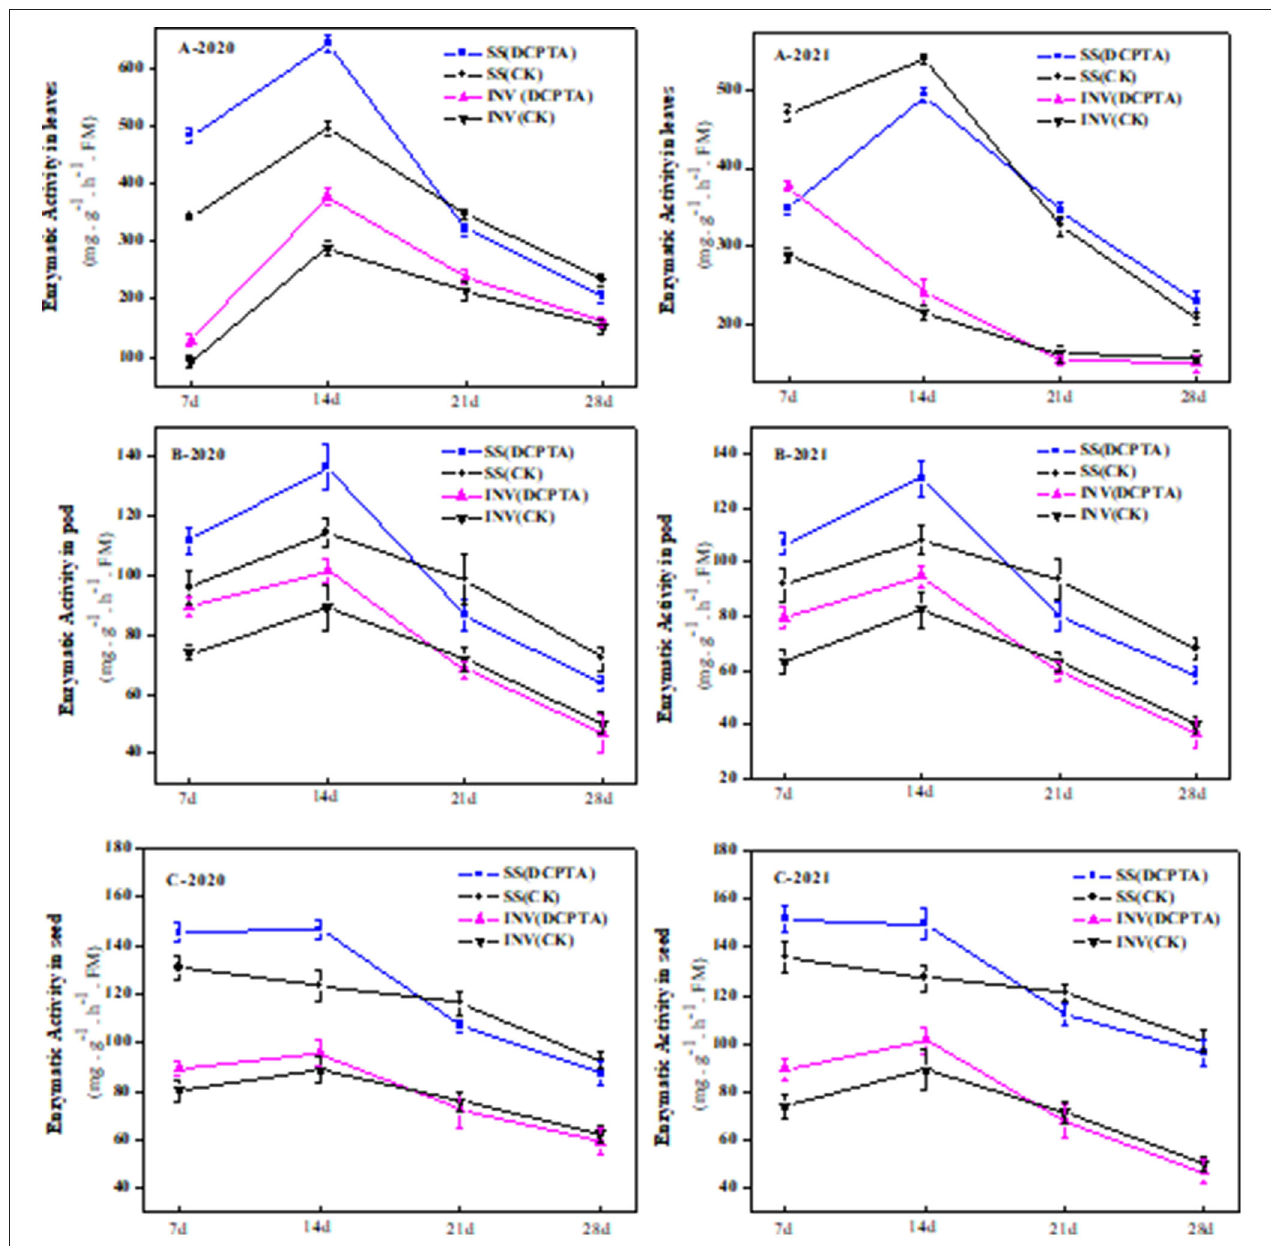
FIGURE 8 | Effects of DCPTA on sucrose synthase and beta-fructofuranosidase in leaves, pods, and grain from 2020 to 2021. (A) Sucrose synthase and beta-fructofuranosidase activity in leaves; (B) Sucrose synthase and beta-fructofuranosidase activity in pods; and (C) Sucrose synthase and beta-fructofuranosidase activity in grain at 7–28 days after spraying in 2020 and 2021. Data were analyzed by ANOVA to separate significance. Vertical bars represent mean ± SE from three independent replicates and the different letters denote significant differences ( p <